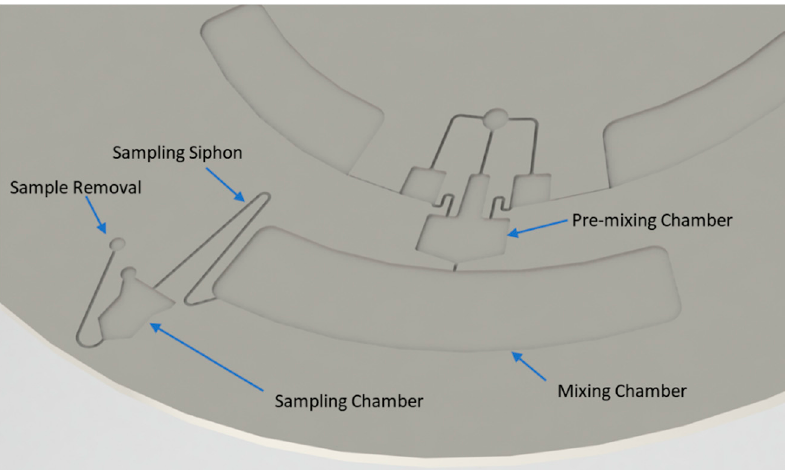
Figure 5. Representation of modified structure used to aliquot samples of plasma/PBS mixture. After mixing is complete disc is stopped to allow Sampling siphon to prime. Disc is then rotated to transfer 1.5 µL into sampling chamber (i.e., lower part of sampling chamber is filled). This sample is then removed from sampling chamber and process is repeated until mixing chamber is emptied.